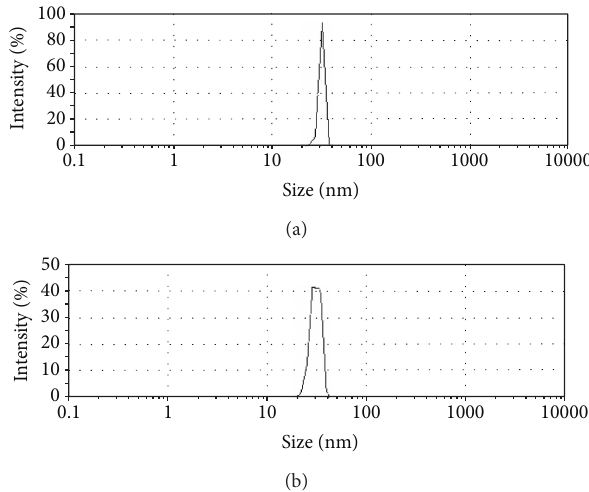
Figure 1: Particle size distribution curves of Ag-SiO 2 (a) and Cu- SiO 2 (b); average particle size 30